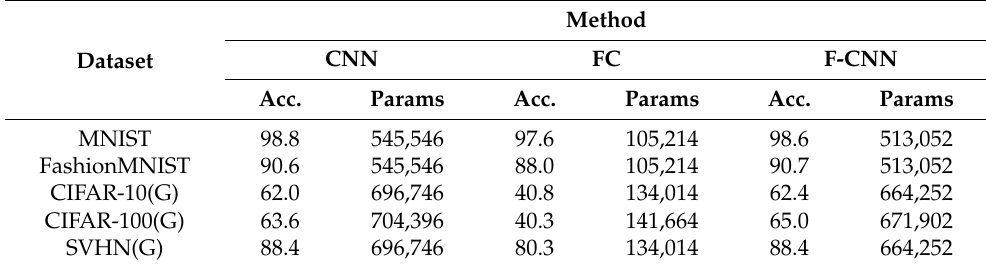
Table 3. Accuracy (%) of LeNet-5 on gray-scale image datasets.